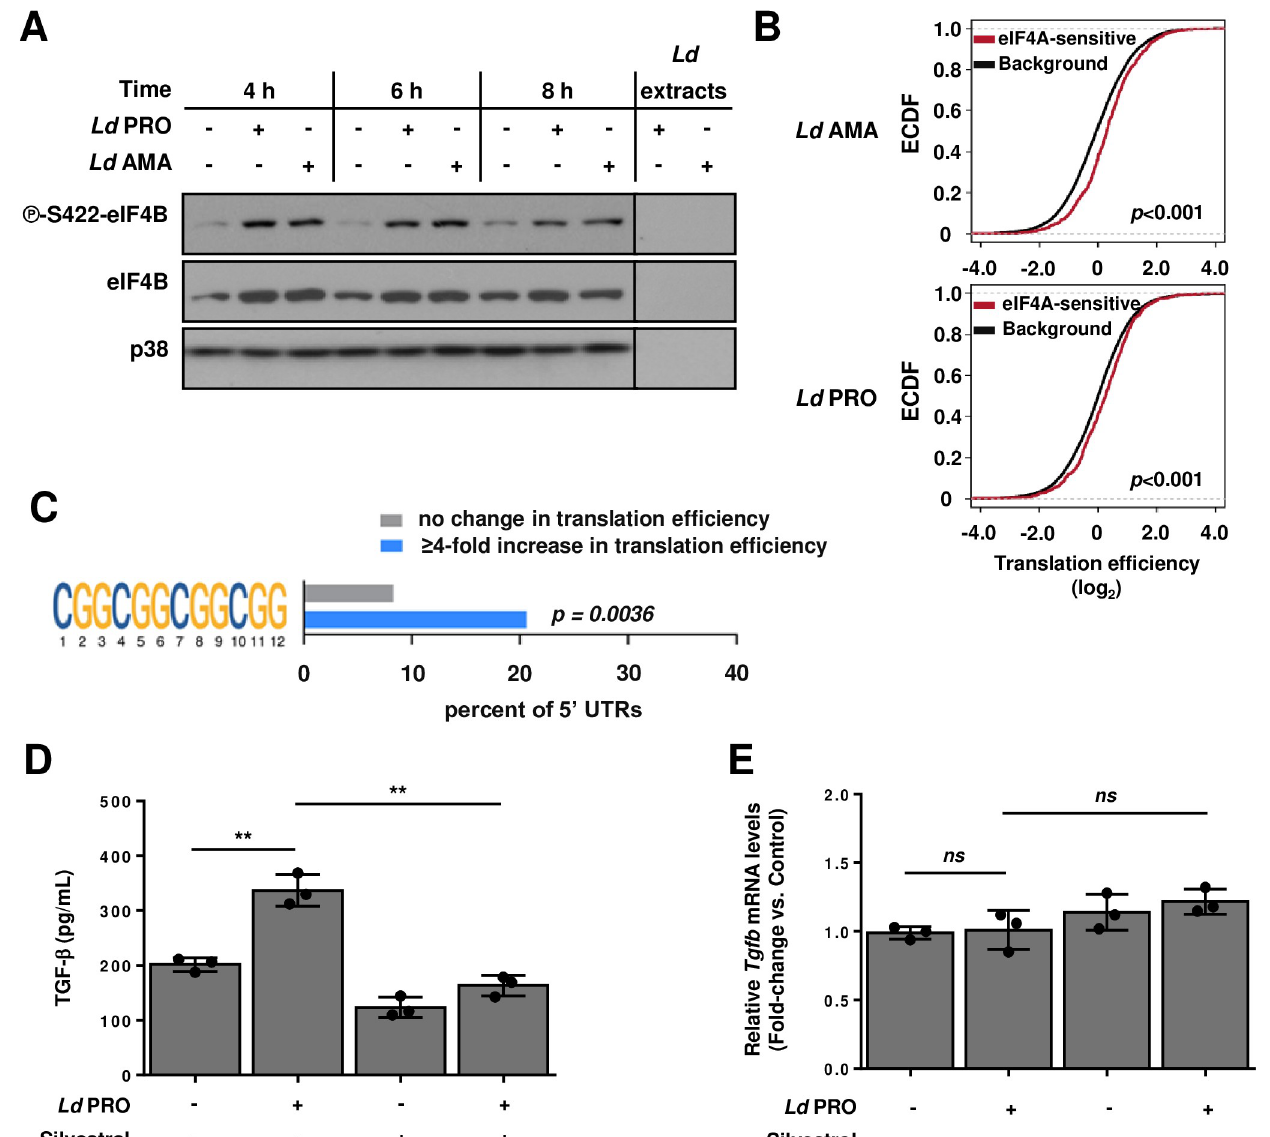
Fig 5. L . donovani infection activates eIF4A-sensitive mRNA translation in macrophages. ( A ) BMDM cultures were inoculated with Ld AMA, Ld PRO or left uninfected for the indicated times. Phosphorylation status and expression levels of eIF4B were monitored by Western blotting. Total levels of p38 MAPK were used as a loading control. ( B ) Empirical cumulative distribution function (ECDF) of translational efficiencies (infection vs. control) for the compilation of previously reported eIF4A-sensitive transcripts as compared to those of all detected transcripts (background). Differences in translational efficiencies between eIF4A-sensitive vs control transcripts were assessed per parasite stage. ( C ) Percentages of infection-associated translationally activated mRNAs ( � 4-fold increase) with at least one (CGG) 4 motif in their 5’ UTR as compared to a random set of unchanged mRNAs. Fisher’s exact test was used to compare frequencies of the (CGG) 4 motif between the transcript subsets and the resulting p -value is indicated. ( D - E ) BMDM cultures were pre-treated with 25 nM silvestrol or vehicle for 2 h, then were inoculated with Ld PRO or left uninfected for 6 or 24 h. ( D ) Secreted levels of TGF- β (24 h post-infection) were measured by sandwich ELISA. ( E ) Relative amount of Tgfb1 mRNA (6 h post-infection) (normalized to Actb ) was measured by RT-qPCR. ( A ) Results are representative of three independent experiments. ( B-C ) Data analyses were performed on samples generated from at least three biological replicates. ( D - E ) Data are presented as mean ± SD (biological replicates, n = 3). � p < 0.05, �� p < 0.01 (for the indicated comparisons), ns = non-significant. Cell culture supernatants for ELISA experiments (D) originate from one of the three biological replicates employed to isolate RNA samples for RT-qPCR analyses